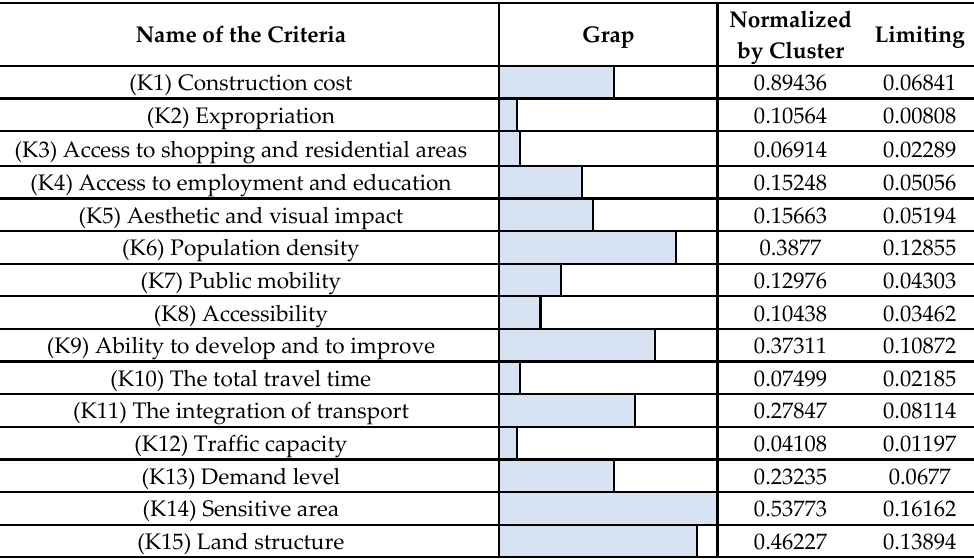
Table 4. Weights of the criteria.